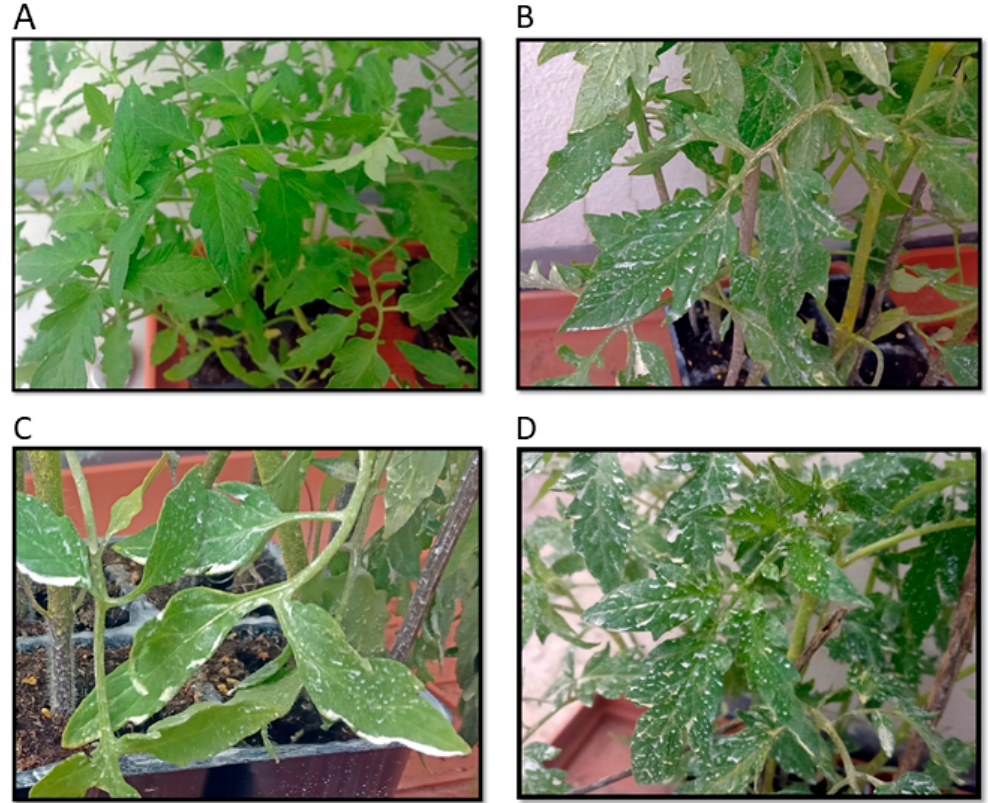
Figure 5. Visual appearance of sprayed plants 5 days post spraying: ( A ) Control, ( B ) PMP-1, ( C ) PMP-2, and ( D ) PMP-3.